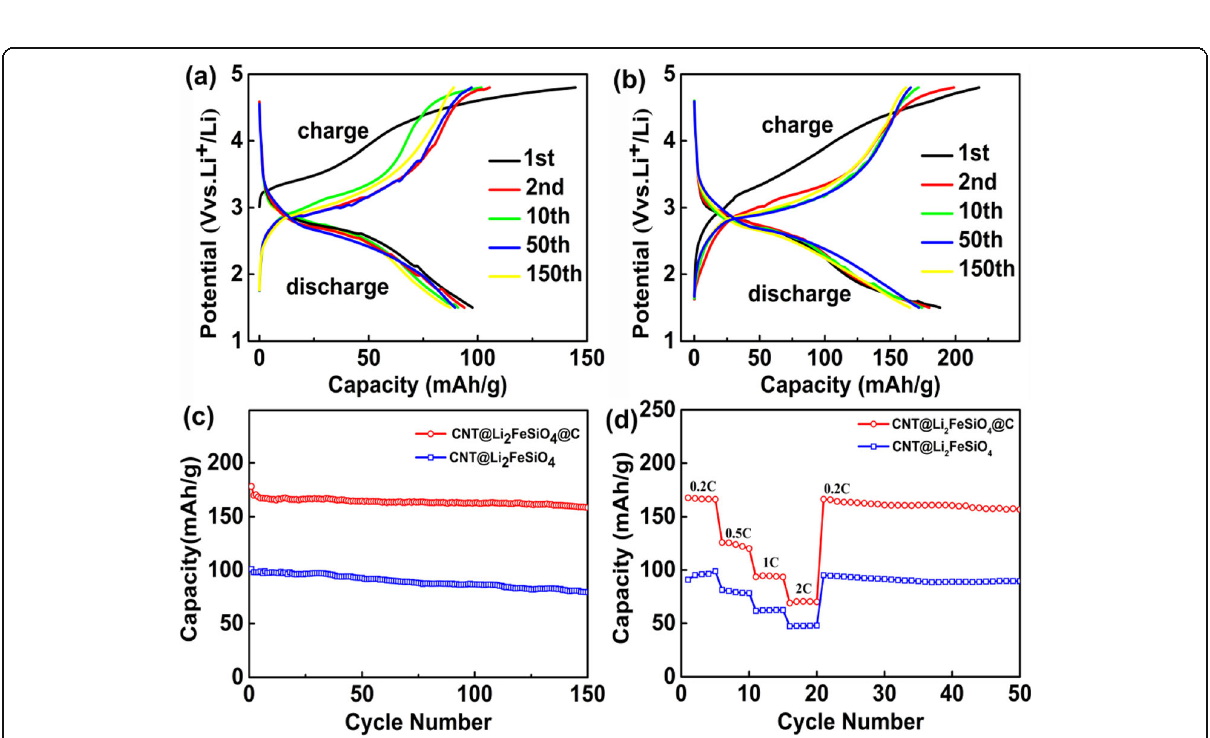
Fig. 4 a The charge/discharge curves of CNT@Li 2 FeSiO 4 electrode at the rate of 0.2 C, b the charge/discharge curves of CNT@Li 2 FeSiO 4 @C electrode at the rate of 0.2 C, c the cycling performance of CNT@Li 2 FeSiO 4 and CNT@Li 2 FeSiO 4 @C electrode, and d the rate performance of CNT@ Li 2 FeSiO 4 and CNT@ Li 2 FeSiO 4 @C